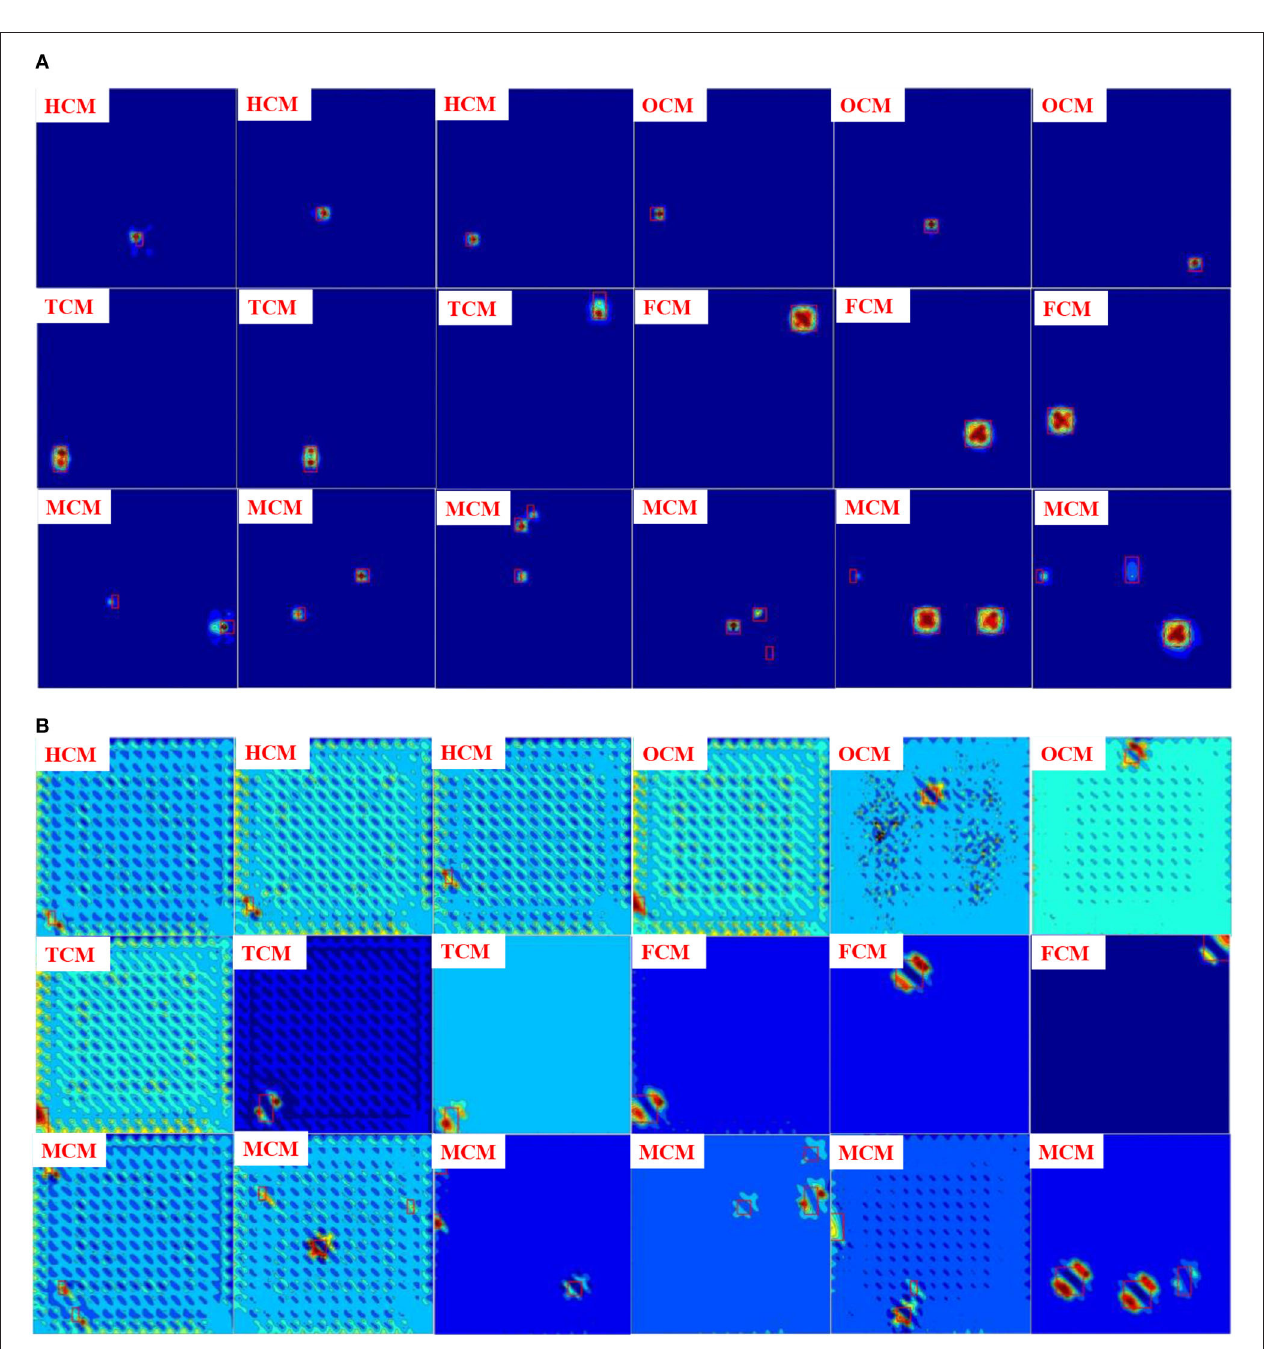
FIGURE 5 | Samples of datasets based on (A) DI-1 and (B) DI-2. HCM, half-cell missing; OCM, one cell missing; TCM, two cells missing; FCM, four cells missing.